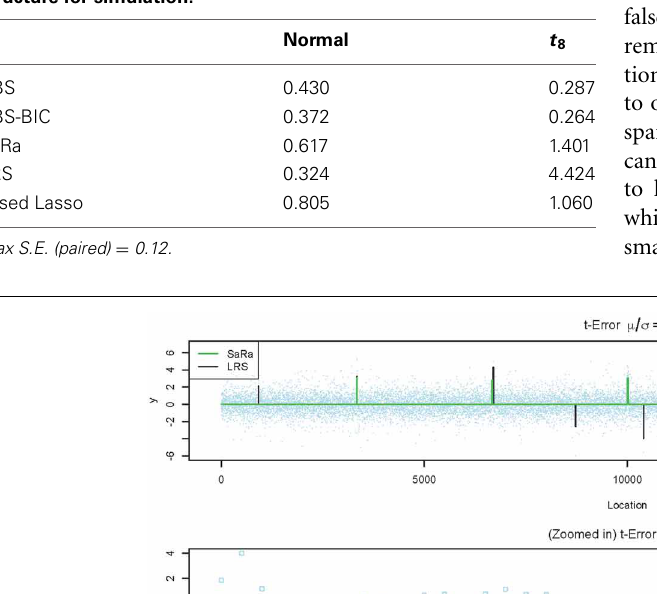
magnitude between two algorithms for one false positive. The bottom figure is the result of removing small width aberrations. This now matches the true simulated profile for LRS but the false positive for SaRa